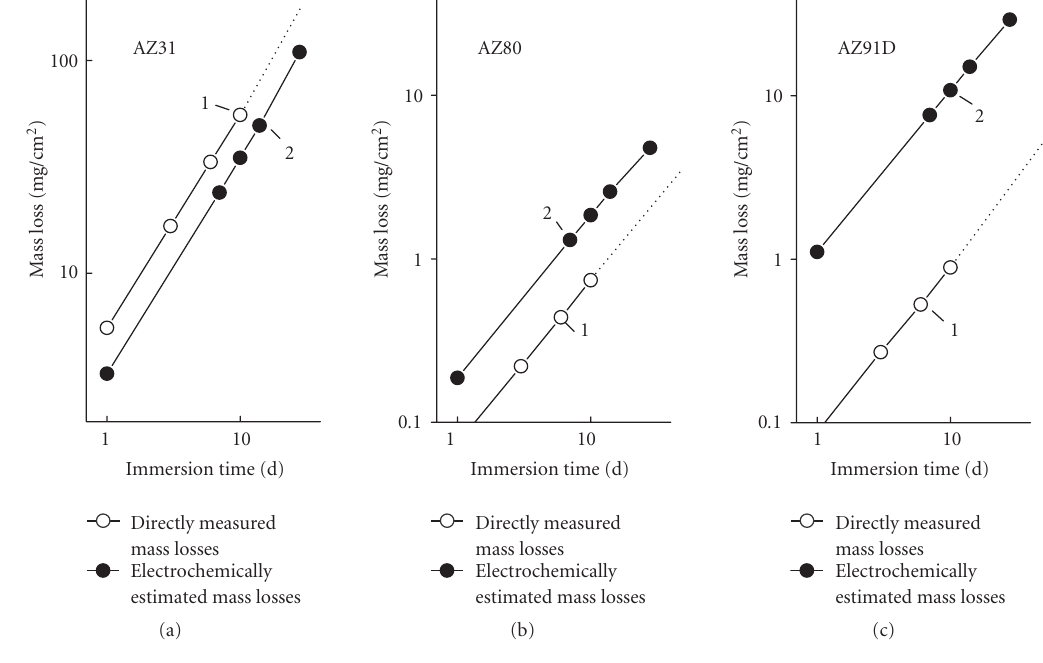
Figure 5: Variation of mass losses with time